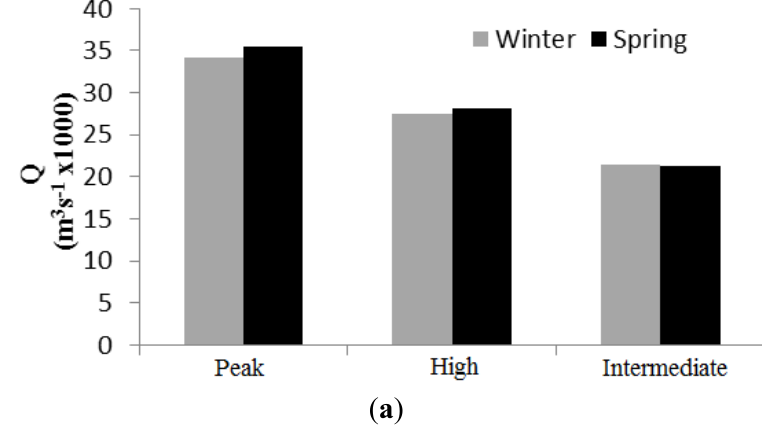
Figure 5. Mean river discharge ( a ); suspended sediment concentration ( b ); and suspended sediment load ( c ) under three stage categories during spring and winter